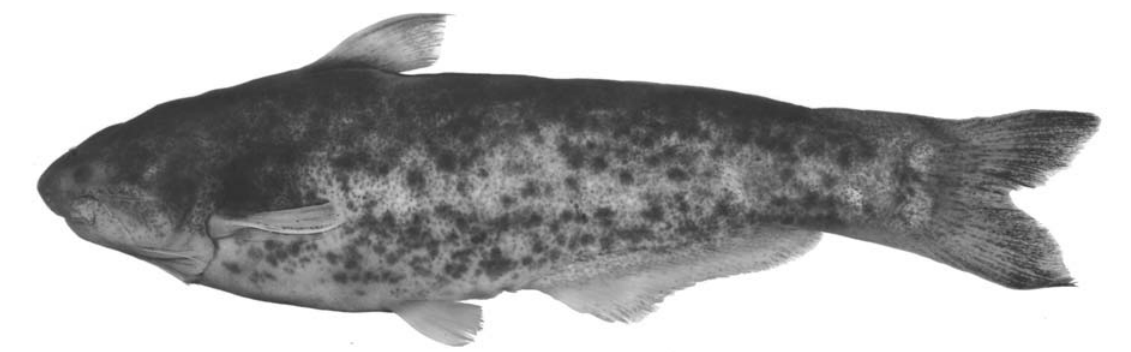
Fig. 32 . Cetopsis orinoco , INHS 27880, 81.5 mm SL; Venezuela, Barinas, Caño Curito (7°22’N,